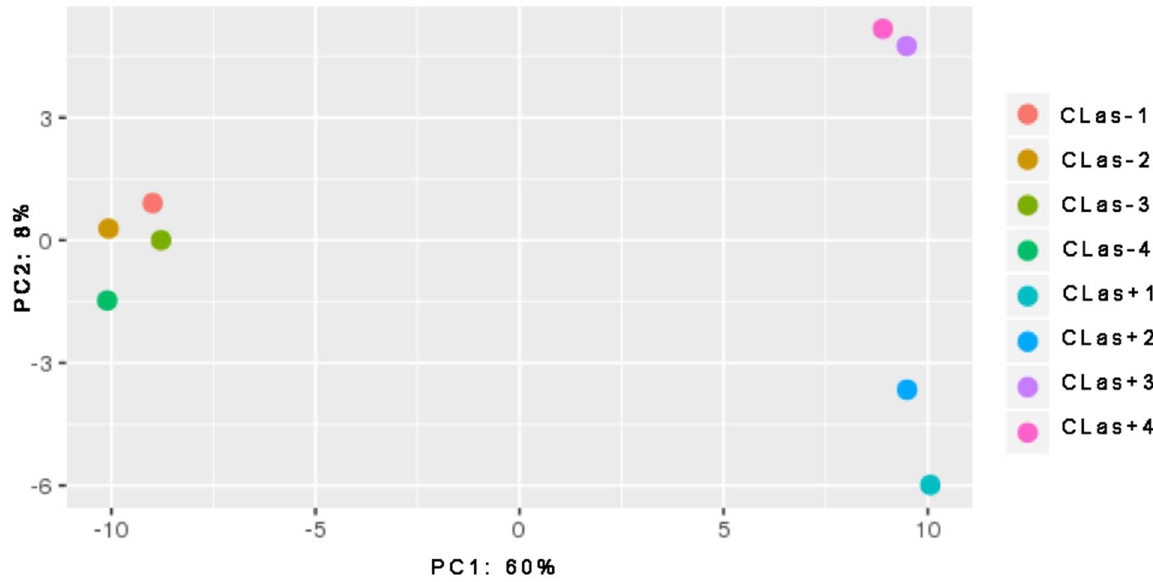
Fig 1. Principle components analysis (PCA) showing variations among replicates of RNA sequencing data. Four different replicates for each sample, either CLas exposed(CLas+) or non-exposed (CLas-, psyllidsreared on healthy citrus plants) are plotted on the PCA plot. Approximately 60% of the variationis seen in principlecomponent(PC) 1, which can be explainedby differencesin the CLas status of the samples (either + or -). Variationin PC2 is much less, 8% and can be ascribedto expressionvariationamong CLas+ samples.